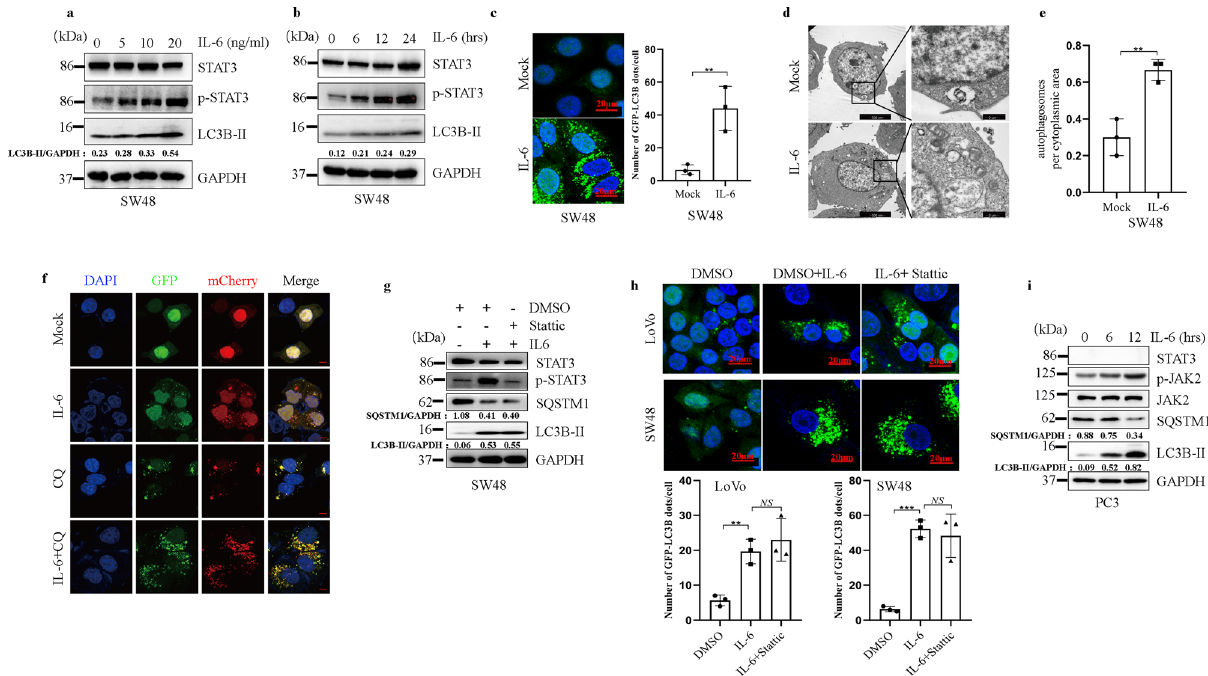
Fig. 1 IL-6 triggers autophagy in cells via a STAT3-independent pathway. a , b Exogenous IL-6 (20 ng/ml) promotes the accumulation of LC3B-II in SW48 cells treated with IL-6 in a dose- ( a ) and time-dependent ( b ) manner. Western blotting was performed to examine the expression of LC3B-II and SQSTM1. ( n = 3 independent experiments). c Exogenous IL-6 (20 ng/ml) promotes the accumulation of GFP-LC3B puncta in SW48 cells. Immuno fl uorescence (IF) staining analyses of GFP-LC3B3 puncta in SW48 cells treated with IL-6 (20 ng/ml) for 12 h. Quantitative analysis of GFP-LC3B puncta is shown in the right panel. ** P < 0.01. Scale bars, 20 μ m ( n = 3 independent experiments). d , e Representative images from transmission electron microscopy showing autophagosomes (arrows) in SW48 cells after treatment with IL-6 (20 ng/ml) ( d ). Quantitative analysis of autophagosomes is shown in the right panel ( e ). ** P < 0.01. Scale bars, 5 μ m ( n = 3 independent experiments). f Examination of autophagic fl ux with the mCherry-GFP-LC3 reporter in SW48 cells. SW48 cells stably expressing the mCherry-GFP-LC3B fusion protein were separately treated with IL-6 (20 ng/ml) in the absence or presence of CQ (25 μ M). Confocal microscopy images are shown. Scale bars, 20 μ m ( n = 3 independent experiments). g Western blotting was performed for SW48 cells separately treated with IL-6 (20 ng/ml) in the absence or presence of Stattic (20 μ M) for 12 h ( n = 2 independent experiments). h SW48 and LoVo cells stably expressing GFP-LC3B fusion protein were separately treated with IL-6 (20 ng/ml) in the absence or presence of Stattic (20 μ M) for 12 h. Confocal microscopy images are shown. Quantitative analysis of GFP-LC3B puncta is shown in the lower panels. ** P < 0.01, *** P < 0.001. Scale bars, 20 μ m ( n = 3 independent experiments). i Exogenous IL-6 promotes the accumulation of LC3B-II and the degradation of SQSTM1 in PC3 cells treated with IL-6 in a dose-dependent manner for 12 h ( n = 2 independent experiments). In c , e , and h , the values are presented as the means ± s.d.; p values (Student ’ s t test, two-sided) with comparisons made to the control or different indicated groups are shown. Source data are provided in the Source Data fi